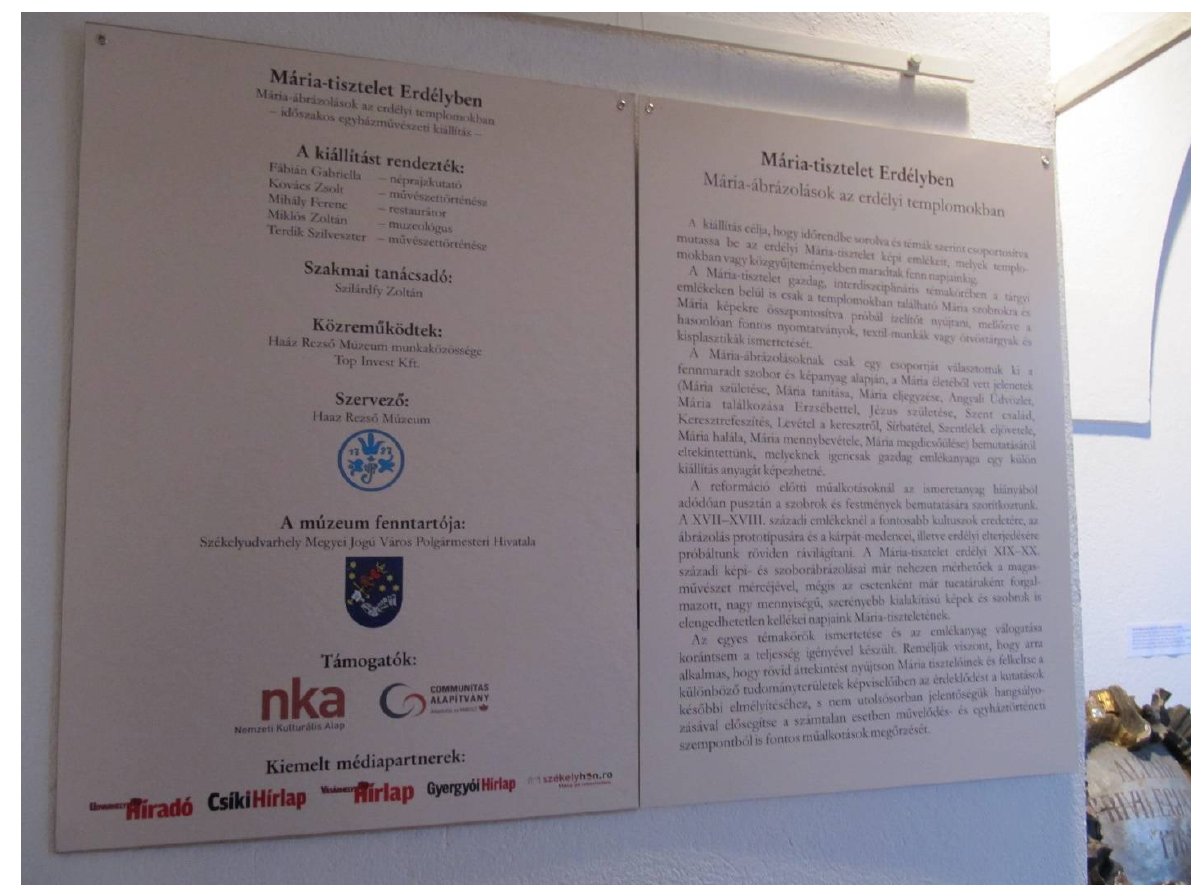
Figure 1. Placard Listing the Exhibition Funders.